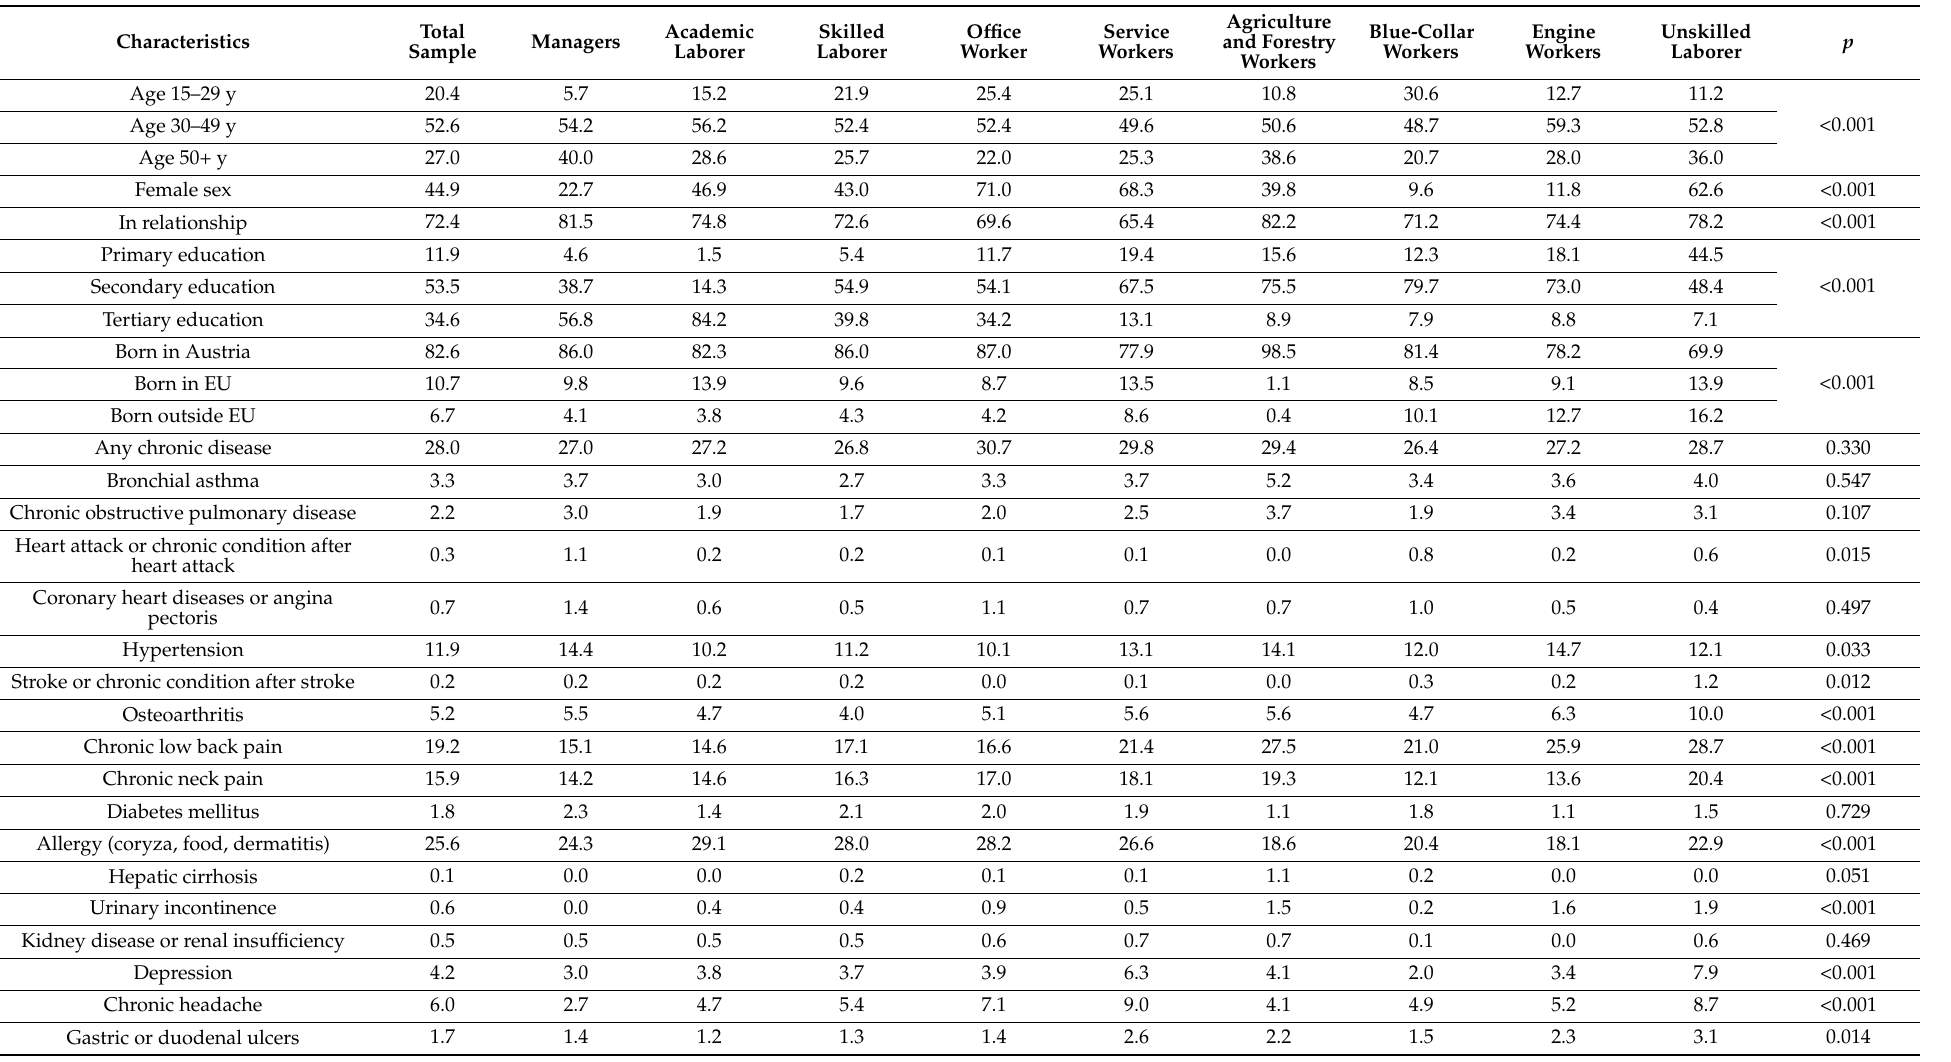
Table 1. Socio-demographic and health-related characteristics of the gainfully employed persons in Austria in total and in different occupational groups (all values in %). Characteristics Total